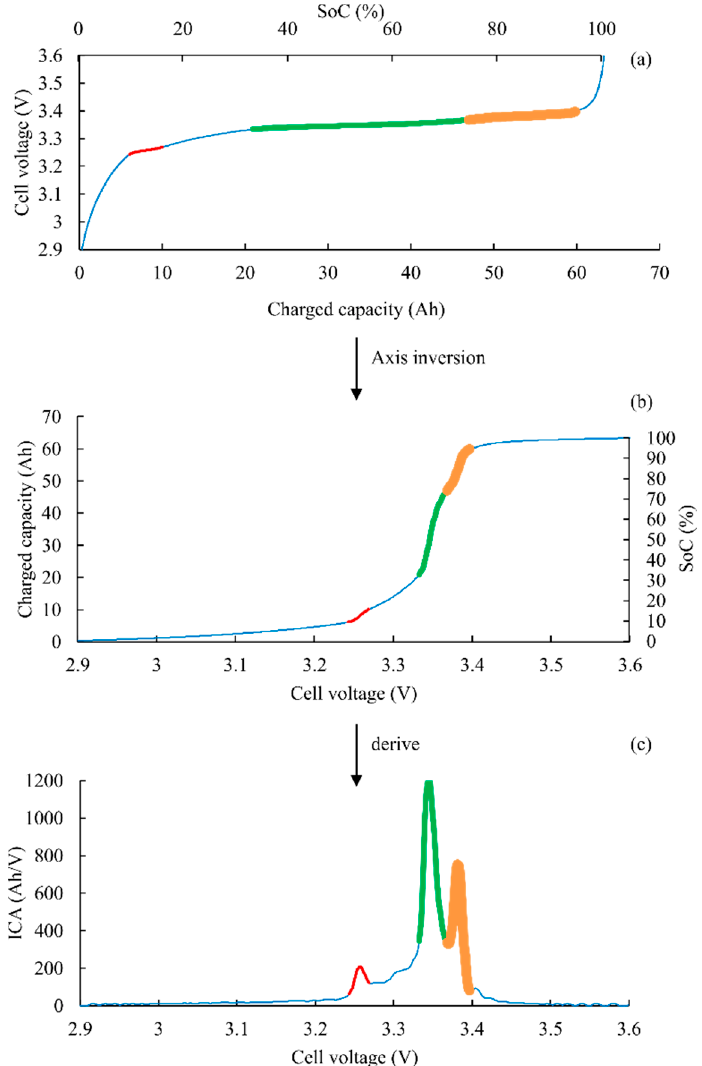
Figure 1. ( a ) LiFePO 4 -C charging curve at C/20; ( b ) Incremental Capacity (IC) construction; ( c ) IC